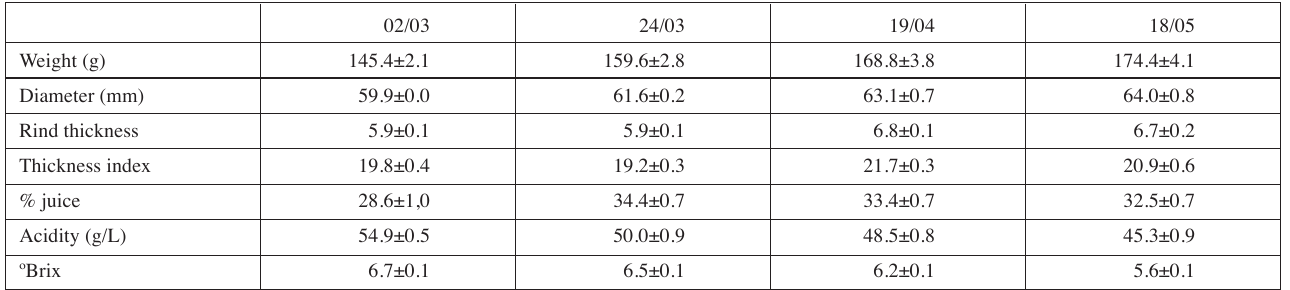
Tab. 1: Characteristics of Verna lemon fruit in different dates